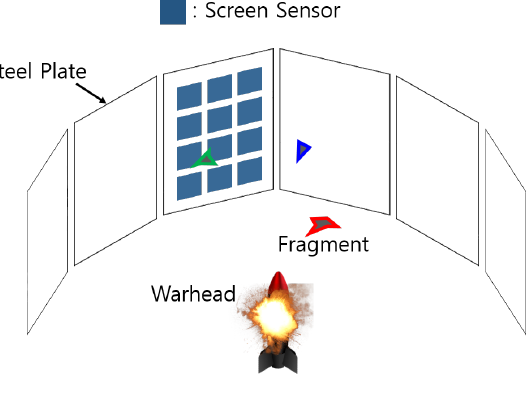
Figure 1. An arena fragmentation test